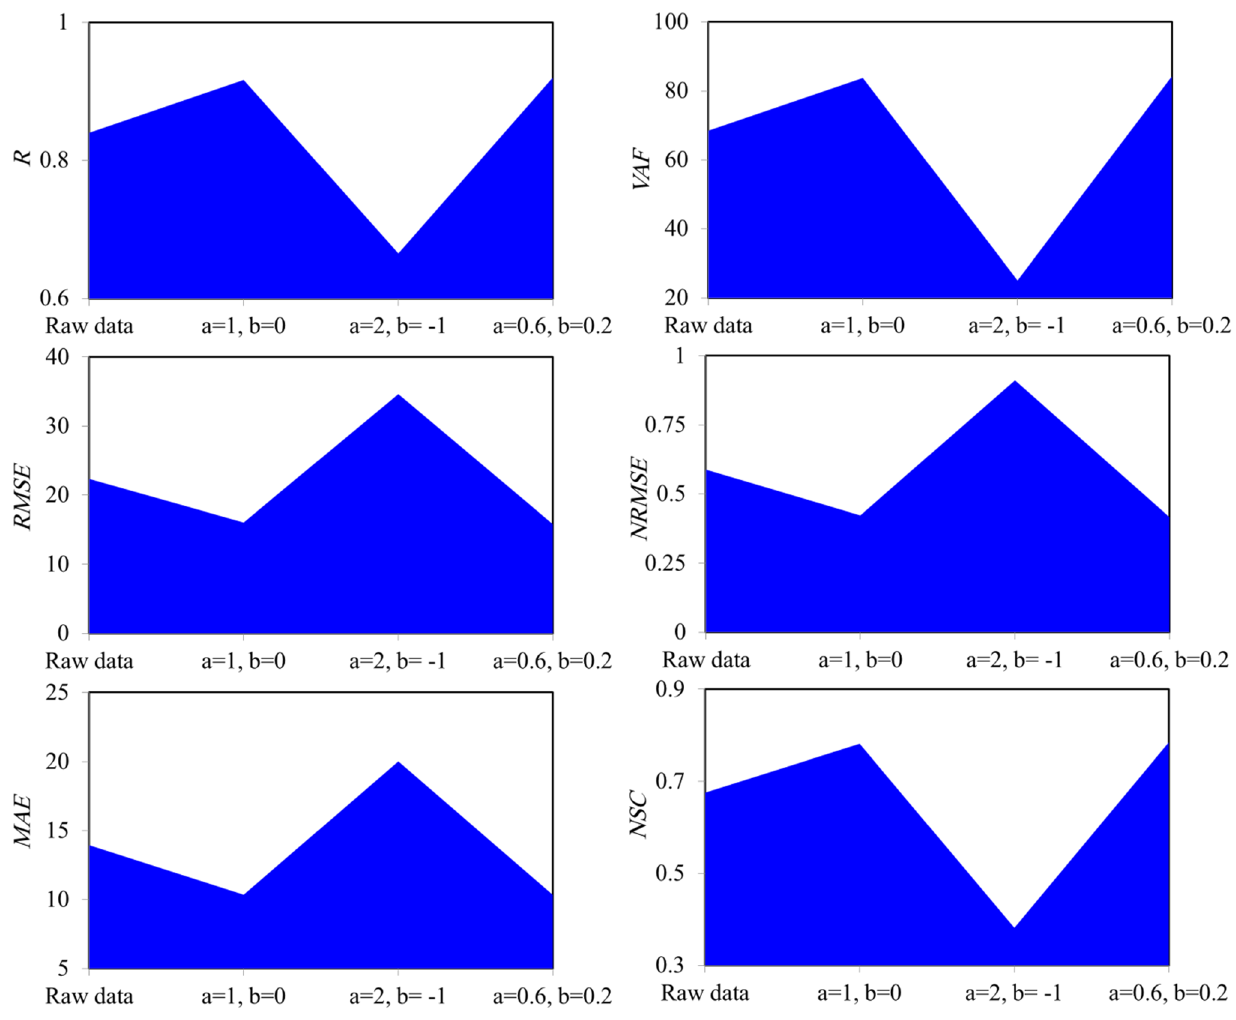
Fig. 3 Results of calculated statistical indices for different normalization coefficients and without normalization